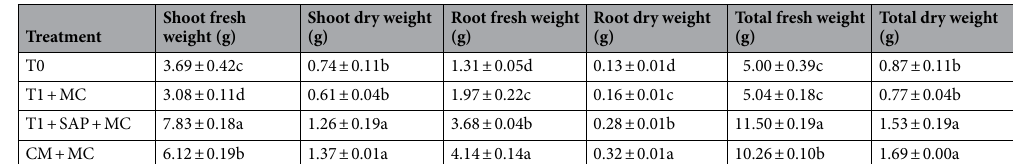
Table 9. Effects of different growing media combined with MC application on the fresh (dry) weight of cotton seedlings. CM commercial media, SAP super absorbent polymer, MC mepiquat chloride foliar painting at the one-true-leaf stage.